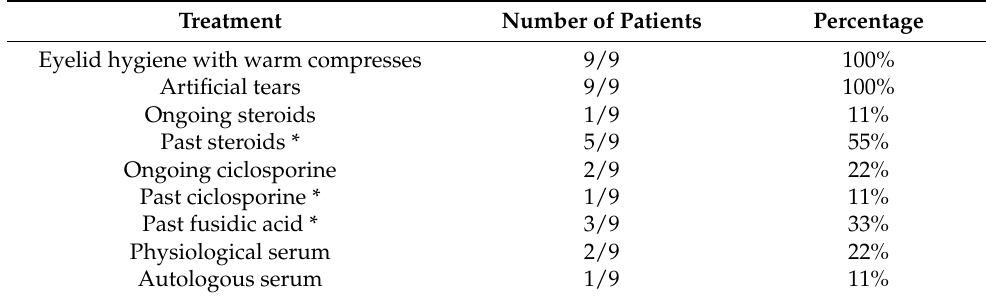
Table 1. Summary of ongoing and past treatments for MGD. * in the month before IPL + LLLT treatment. Treatment Number of Patients Percentage Eyelid hygiene with warm compresses 9/9 100% Artificial tears 9/9